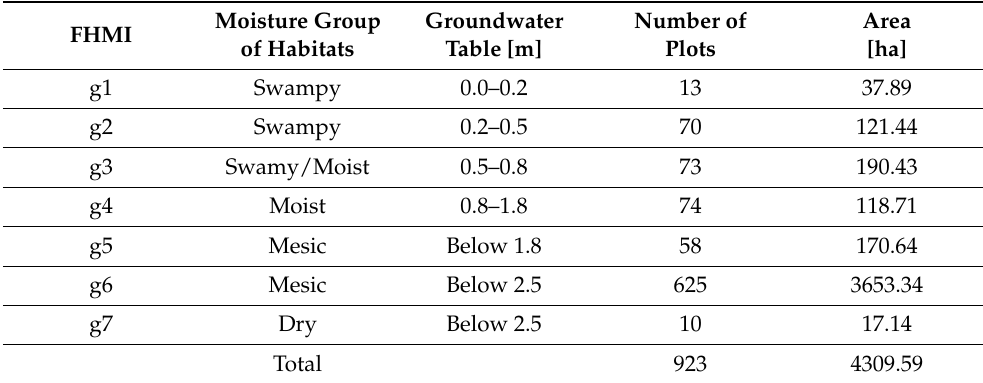
Table 2. Groundwater levels in the FHTs area of the Bory Tucholskie National Park.